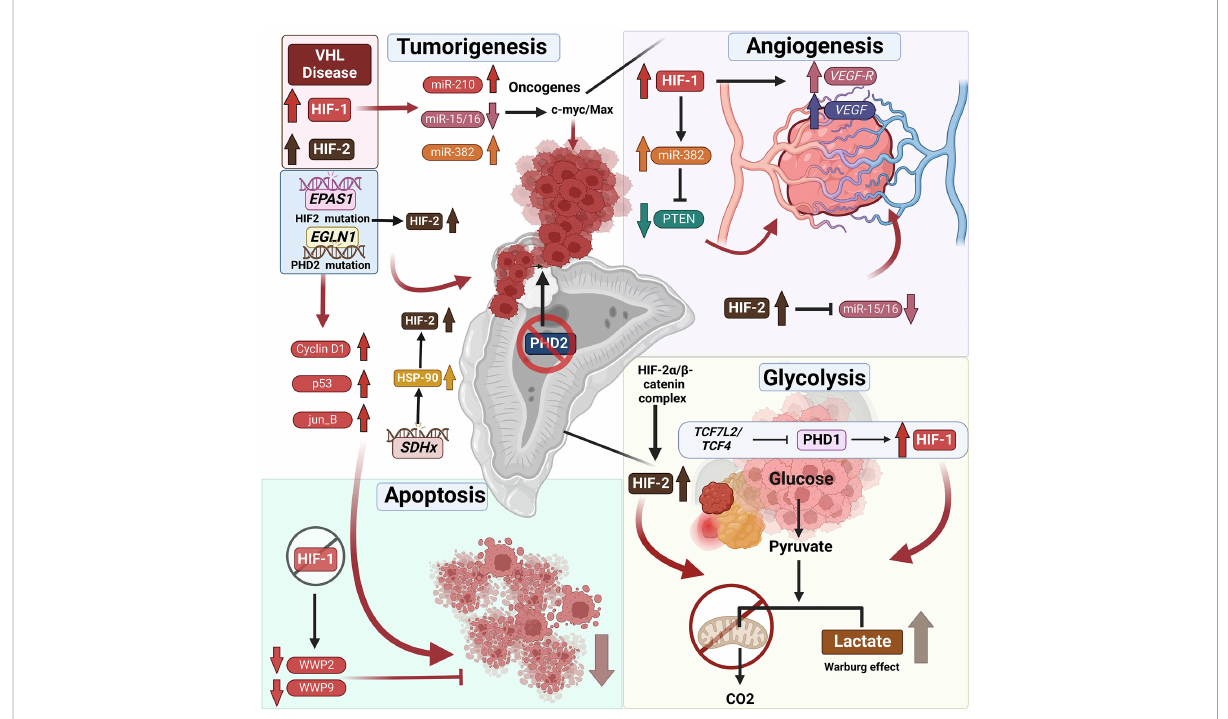
FIGURE 2 Mutations associated with hypoxia pathway proteins and their role in endocrine tumor development. VHL disease leads to the stabilization of HIFs, which is frequently associated with endocrine tumors – speci fi cally pheochromocytomas (PCCs) and paragangliomas (PGLs). Not only does HIF upregulation result in tumorigenesis directly, it also results in reduced apoptosis of endocrine tumor cells. It was shown that HIF-1 a repression induces apoptosis by downregulation of the expression of WW domain containing E3 ubiquitin protein ligase ( WWP9, WWP2) , promoting tumor cell apoptosis. Furthermore, HIF-1 a and HIF-2 a stabilization leads to changes in tumor-associated microRNAs. The HIF- associated increase or decrease in micro-RNAs correlated with upregulation of oncogenes and thus tumorigenesis. Likewise, the mutations in the genes such as EPAS1 or EGLN1 directly affects the stabilization of the HIFs resulting in tumor development and reduced apoptosis of endocrine tumor cells. SDHx mutations in PCCs and PGLs result in the overexpression of the heat shock protein 90 (HSP-90) resulting in the stabilization of HIF-2 a . TH : Cre mediated medullar deletion of PHD2/ EGLN1 in the mice resulted in the growth of aberrant structures from the adrenal medulla. Next to the direct effect of HIF stabilization on the tumor development, it also affects angiogenesis by upregulation of VEGF and VEGFR or miR-15/16 repression initiating angiogenesis. Furthermore, stabilization of HIFs, results in a shift from oxidative phosphorylation to glycolysis, converting pyruvate to lactate in the TCA cycle often mentioned as Warburg effect in the tumors, including endocrine tumors. Additional information can be found in the